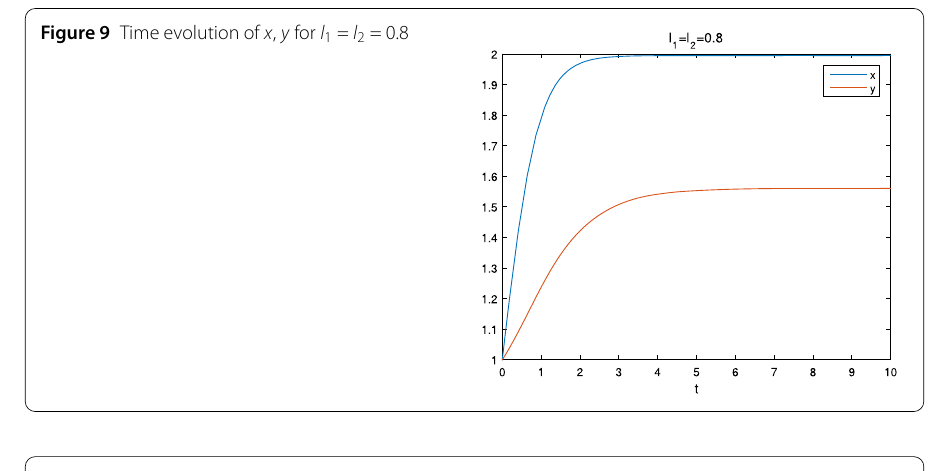
Figure 10 Time evolution of x , y for l 1 = l 2 =